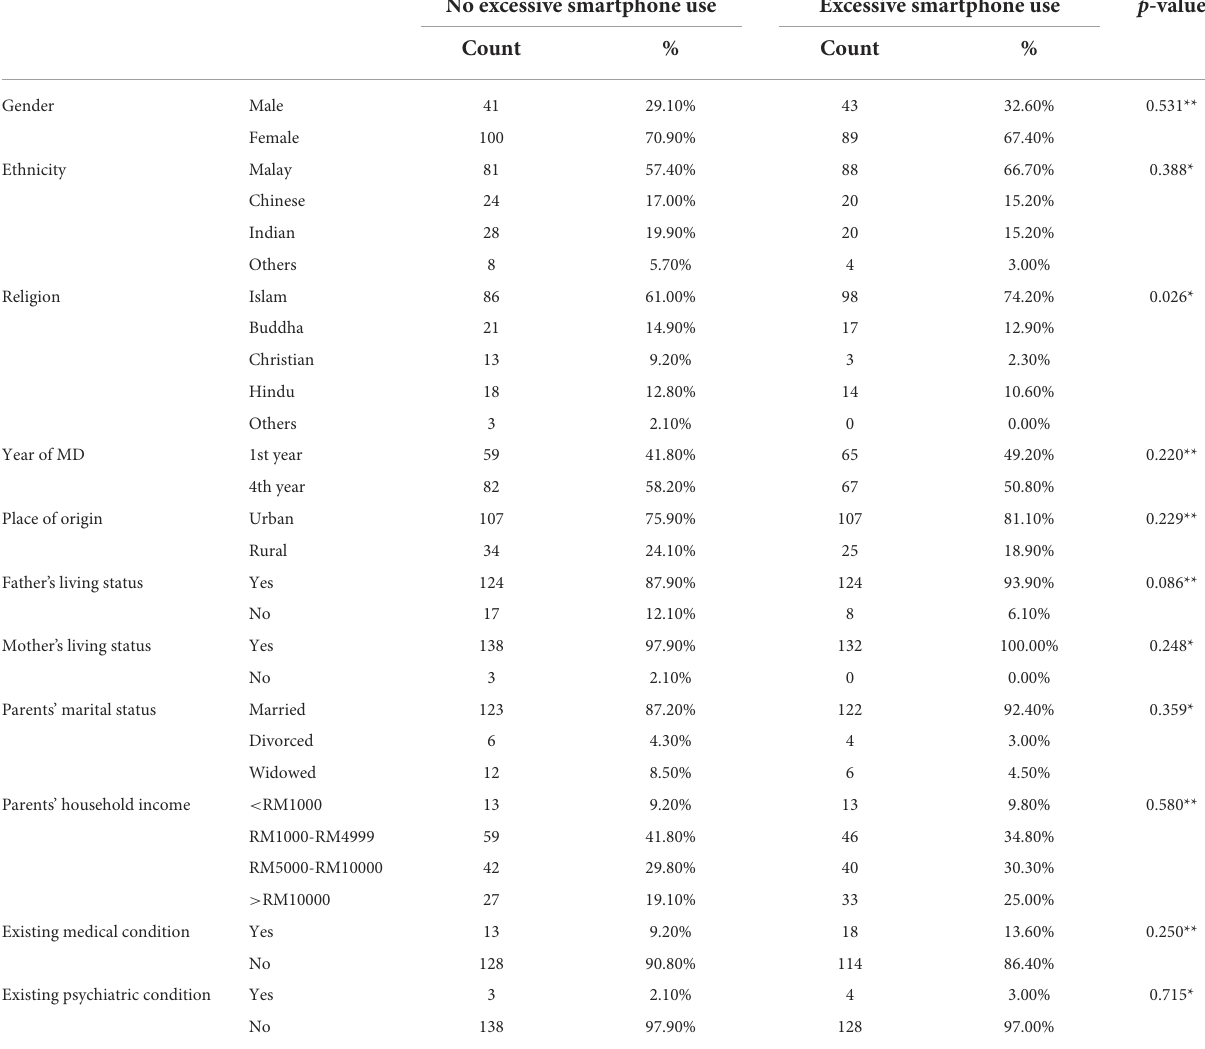
TABLE 1 Sociodemographic information vs. excessive smartphone use.